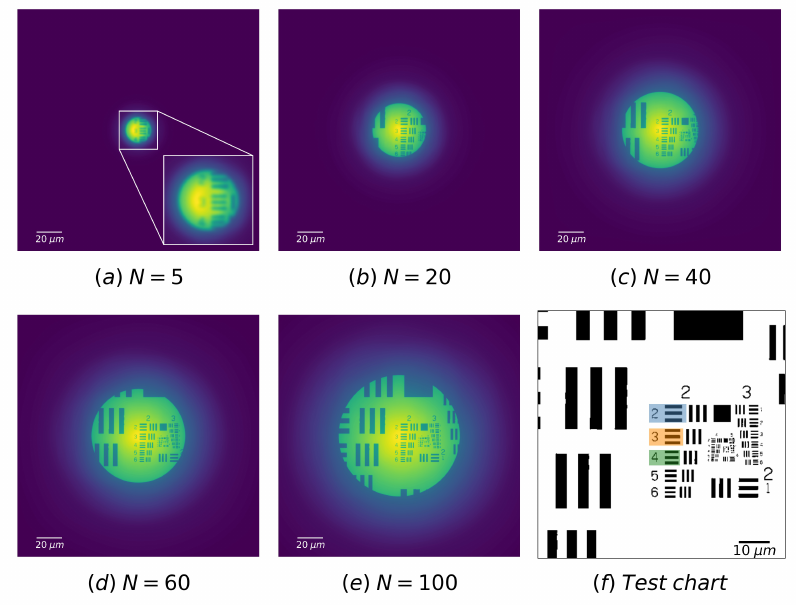
Figure 5. ( a – e ) False color numerical images of the USAF 1951 test target imaged by FZP with different number of zones. The object—FZP distance is 3 f and the FZP–image distance is 1.5 f . Each image dimension is 200 × 200 µ m 2 . ( f ) Zoomed part of interest on the test chart: for the following part, the blue, orange and green colored elements of bars in group 2 are respectively noted as elements 2.2, 2.3, and 2.4.